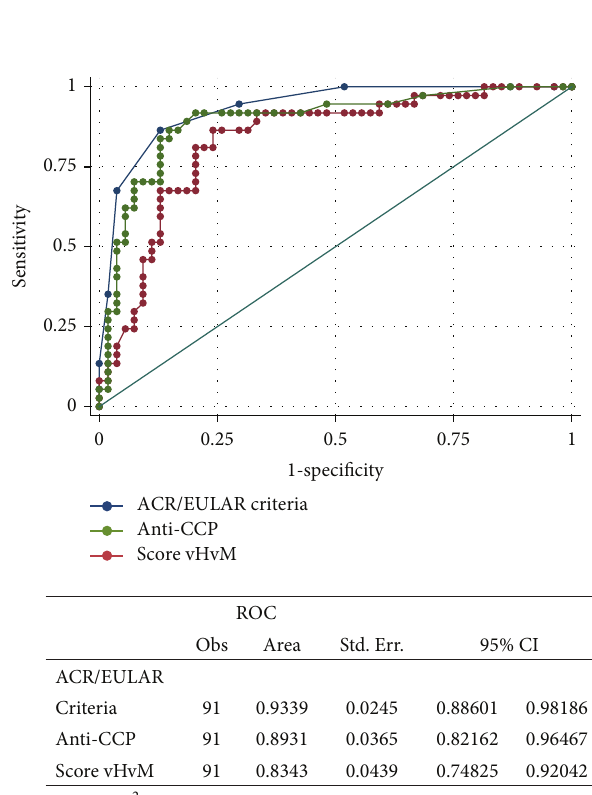
Figure 1: Comparison of receiver operator characteristic (ROC) curve for new ACR/EULAR criteria, van der Helm-van Mil predic- tion score, and anti-CCP antibodies for prediction of development of